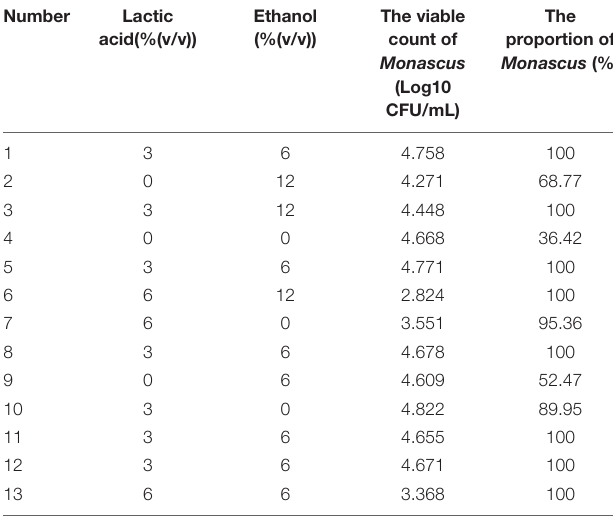
TABLE 1 | Response surface test scheme and results for optimizing the addition of lactic acid and ethanol. Number Lactic